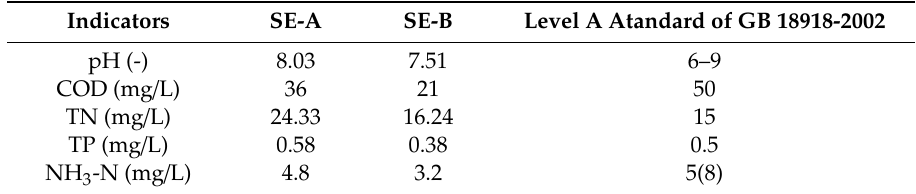
Table 1. The basic water quality indicators of SE-A and SE-B.